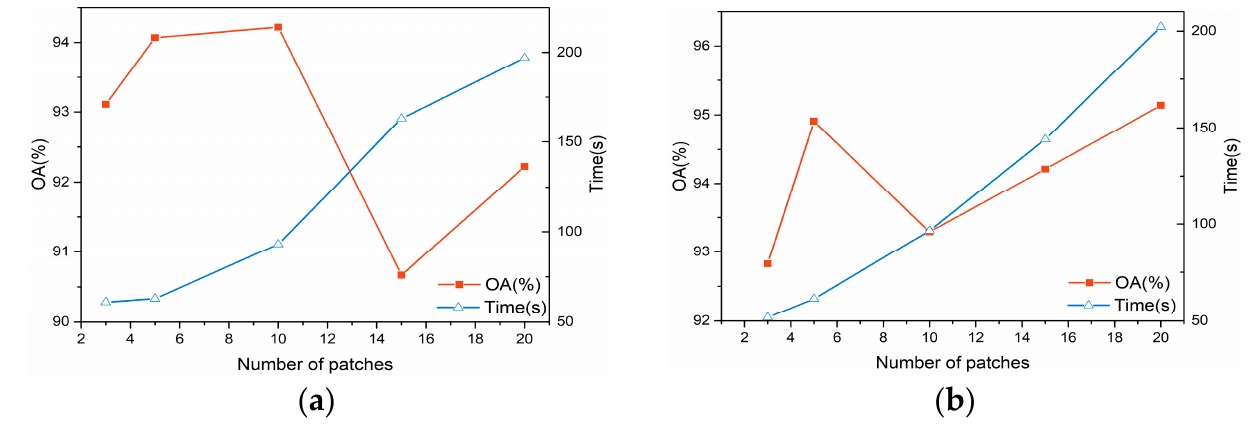
Figure 6. The performance of the RPNet with different numbers of patches. ( a ) S1; ( b ) S2.